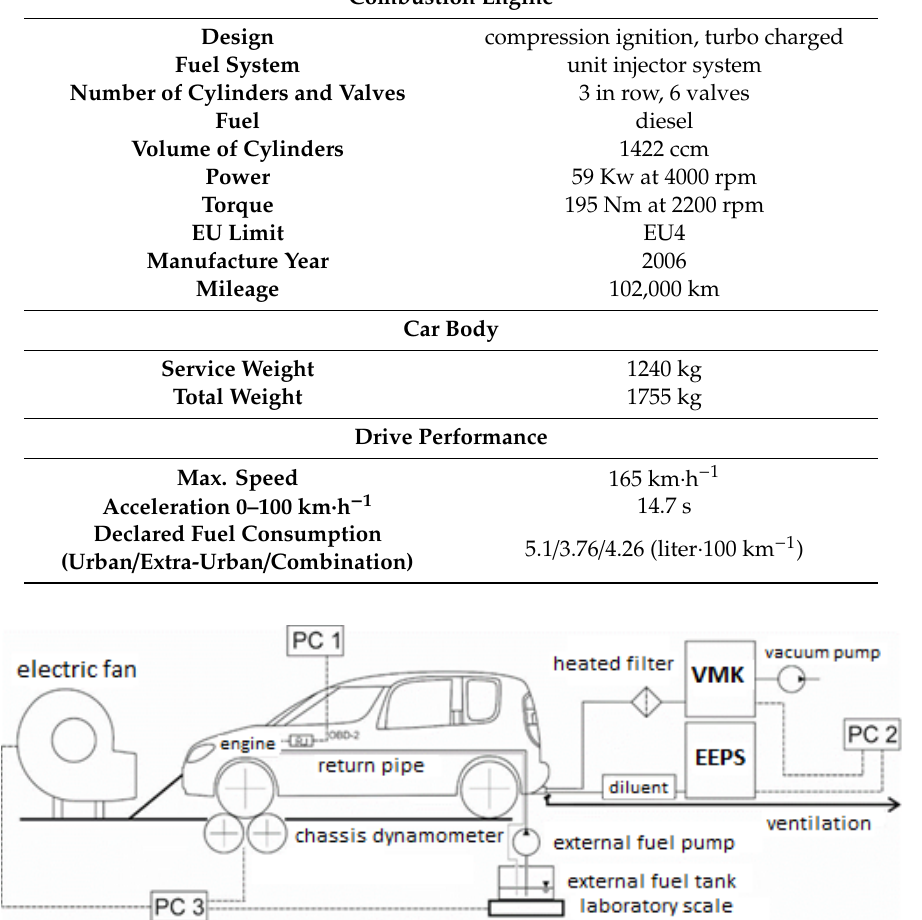
Table 1. Information of Skoda Roomster 1.4 TDI.